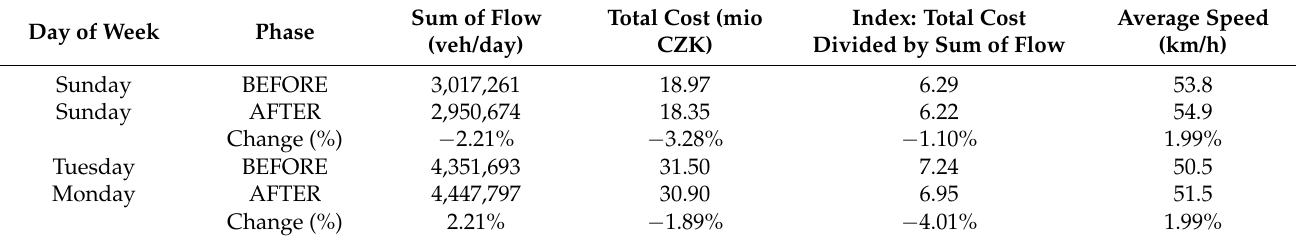
Table 1. BEFORE-AFTER analysis results with respect to changes in the traffic flow (veh), total cost (mio CZK), index and average speed